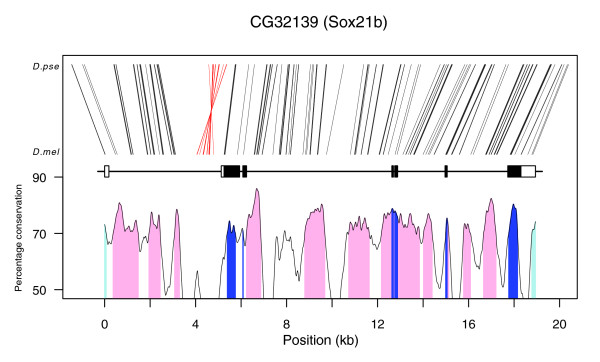
Sequence similarity between Drosophila melanogaster (D. mel) and D. pseudoobscura (D. pse) for the Sox21b (CG32139) gene. Top panel: sliding-window BLAST profile. We stepped through D. melanogaster Sox21b gene in 15 bp increments, and at each position BLASTed a 31 bp segment against the D. pseudoobscura ortholog. Each line represents a BLAST hit with a score above 45, the endpoints show the position of the hit in each genome, and the color of the line represents the orientation of the hit (black = same sequence orientation in each genome, red = different orientations in each genome). Central panel: structure of the Sox21b gene in D. melanogaster. Filled boxes represent exons, and open boxes represent untranslated regions (UTRs). Bottom panel: VISTA plot. The appropriate region of the D. melanogaster-D. pseudoobscura genome alignment was downloaded from the VISTA Browser [44]. We stepped through the alignment in 5 bp increments, and for each 501 bp window calculated the percentage of identical nucleotides between the sequences. The plot is shown relative to the D. melanogaster sequence, and represents a smoothed curve through the data using the ksmooth function in the statistical programming language R [49]. Areas under the curve are painted if they show >70% nucleotide conservation (dark blue = within an exon, light blue = within a UTR, pink = intronic and >100 bp in size).